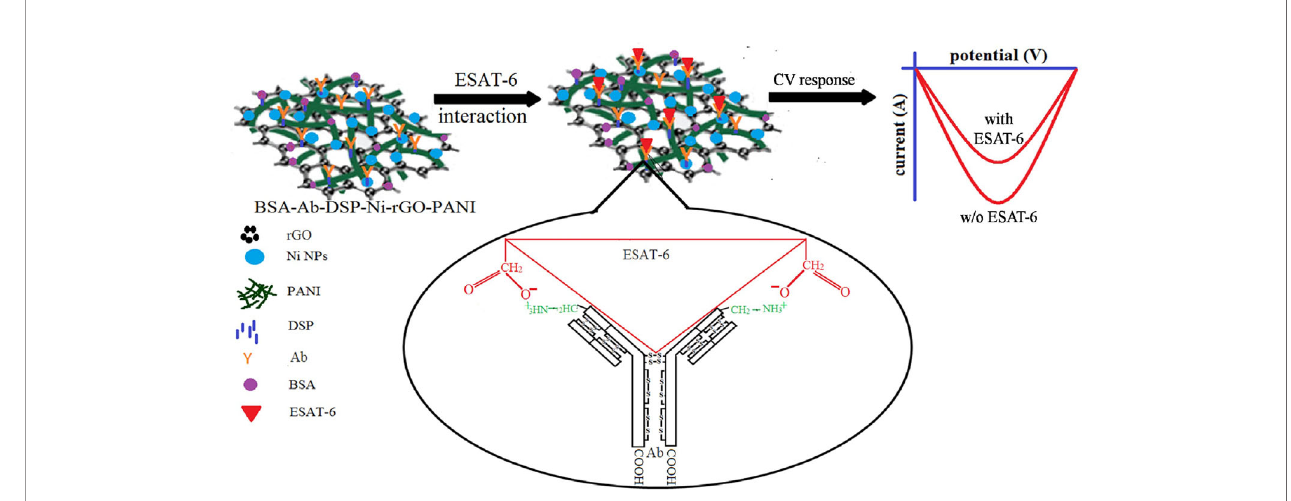
FIGURE 5 | Mechanism of ESAT-6